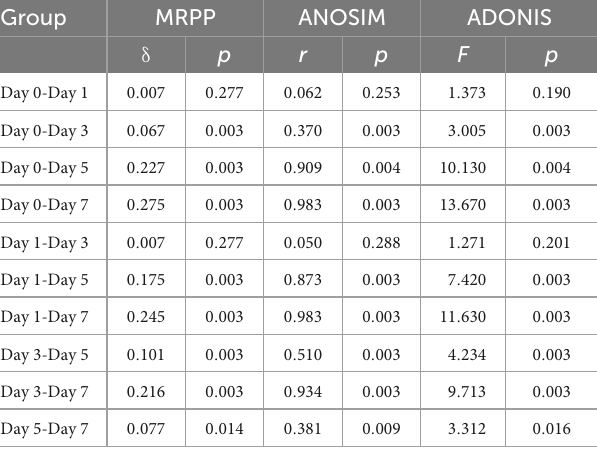
TABLE 1 Significance tests of the differences in bacterial communities of crab paste between fermentation time points.